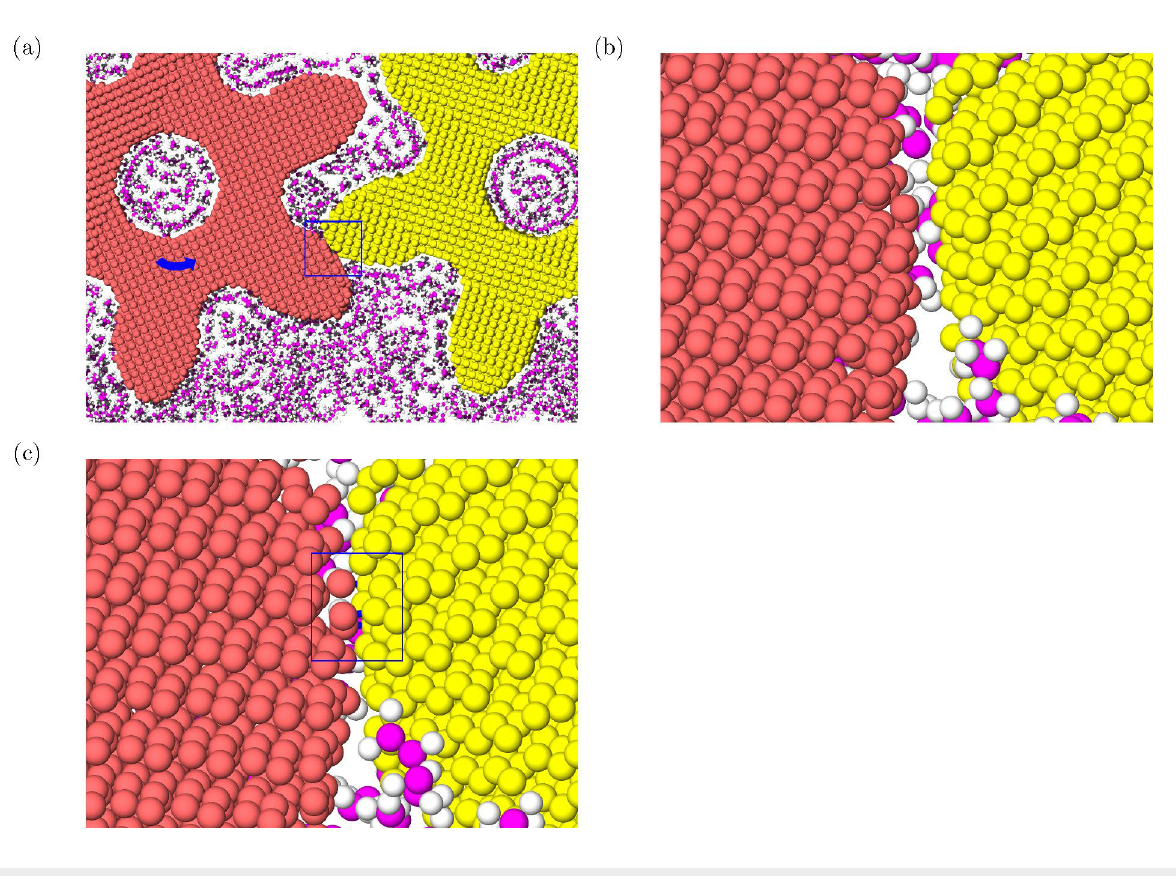
Figure 4: Snapshots for frames around the bond formation event from the MD simulation with center-of-mass distance d CM = 10.4 nm and angular velocity ω = π rad/ns. (a) Top view of the frame at t = 299 ps ( θ 1 ≈ 0.94 rad or 54°). Zoom-in of the area around the teeth (b) before and (c) after the bond formation event ( t = 300 ps). The new bonds between gear carbon atoms (red and yellow for left and right, respectively) are marked in